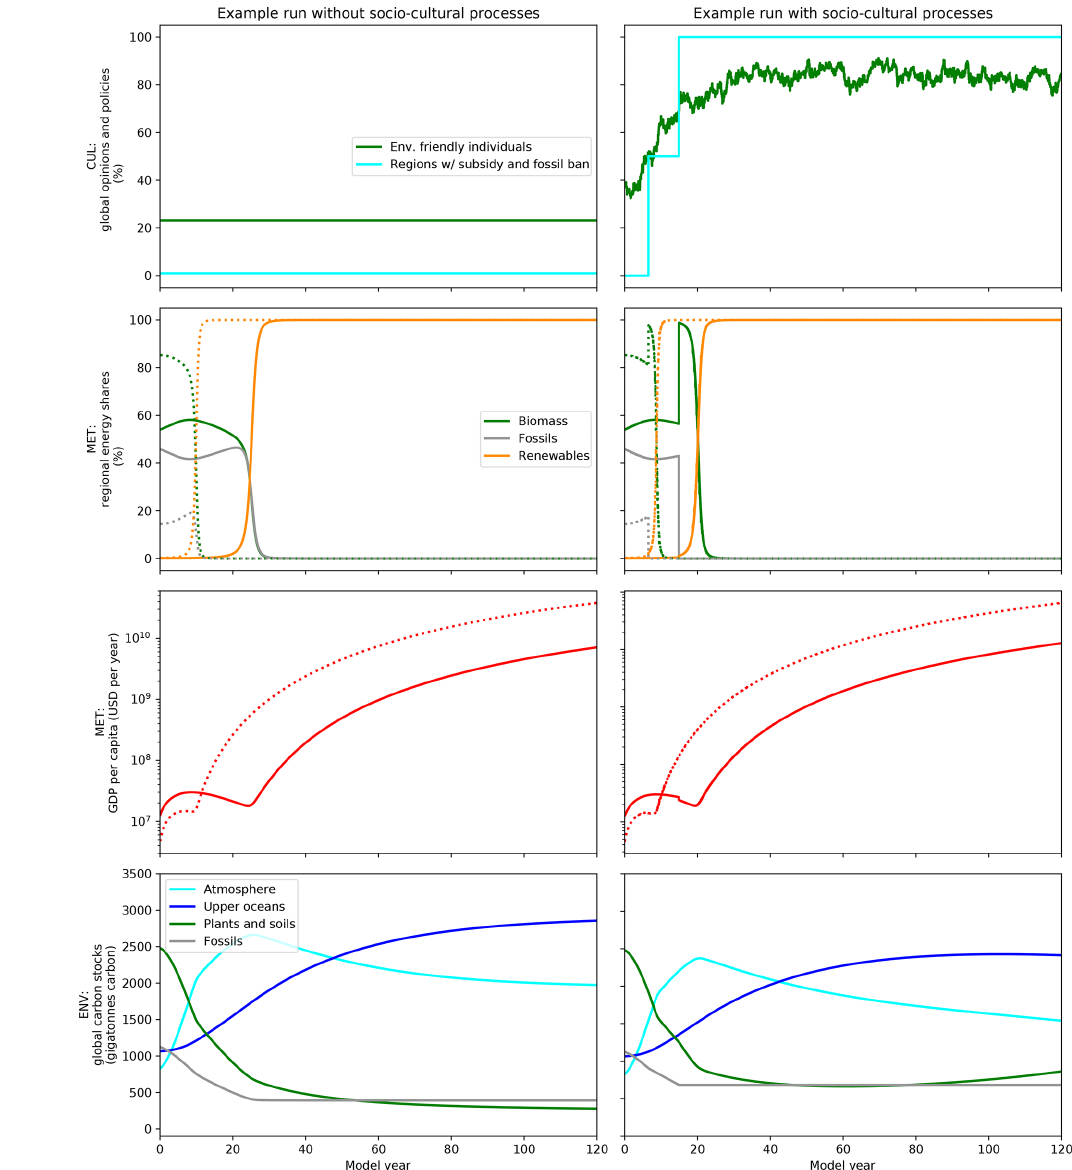
Figure 5. Two runs from a world–Earth model example: one without (left panels) and one with (right panels) the sociocultural processes of environmental awareness, social learning and voting included, showing different transient (and asymptotic) behavior. The top row shows variables related to the cultural process taxon, the second and third row those related to the metabolic process taxon and the bottom row those related to the environmental process taxon. Green, orange, cyan, blue and gray lines correspond to variables related to terrestrial carbon, renewables, atmospheric carbon, ocean carbon and fossils, respectively. In second and third row, dashed lines indicate variables associated with the “Global South”, solid lines to the “Global